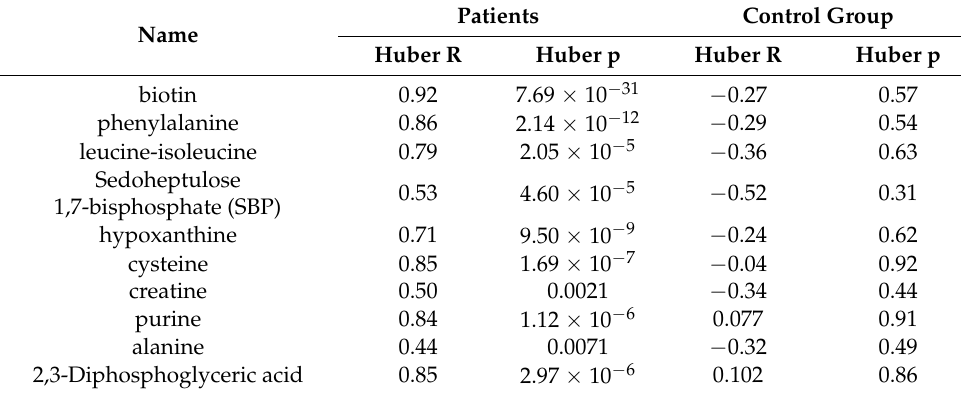
Table 3. Top 10 metabolites (of 53 total) with plasma-CSF correlation lost in control group compared to patients group. Huber R/p denotes the corresponding R- or p-value of the correlation coefficient for the model with Huber M-estimates. For a full list see Table S3,